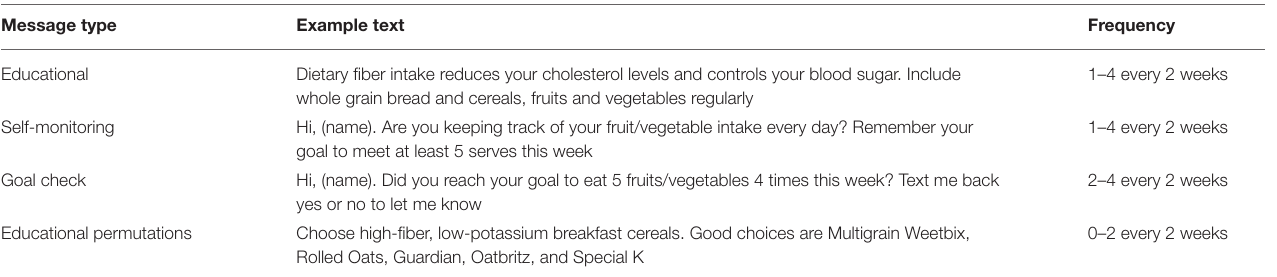
TABLE 1 | Text message type and